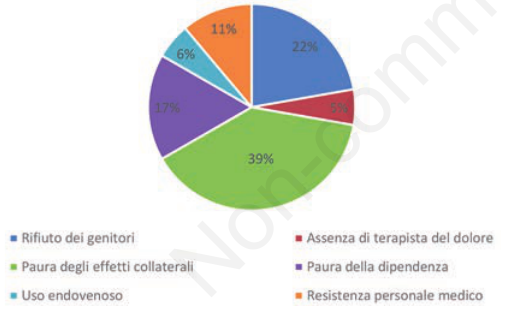
Figura 1. Limiti uso della